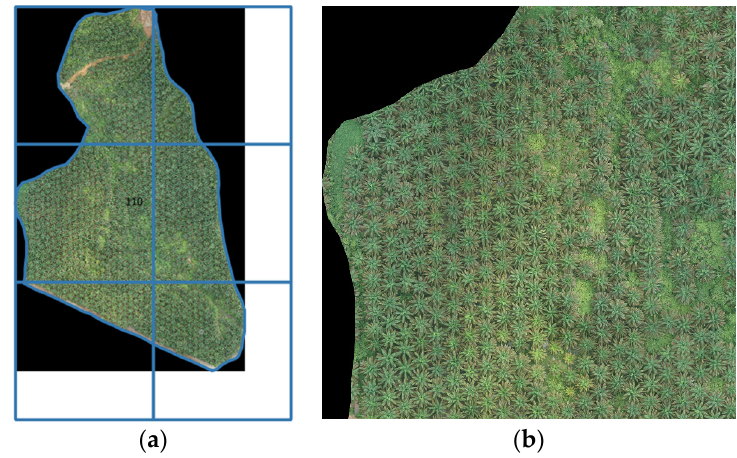
Figure 4. An example of image cropping 3943 × 3943 pixels: ( a ) Mapping on block area; ( b ) Cropping results.